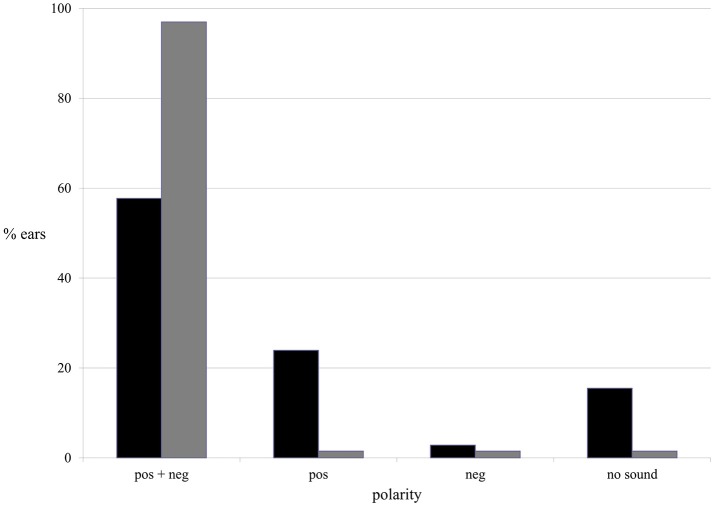
The presence of the AP in terms of current polarity in the tinnitus group (black column) and the healthy students group (gray column).